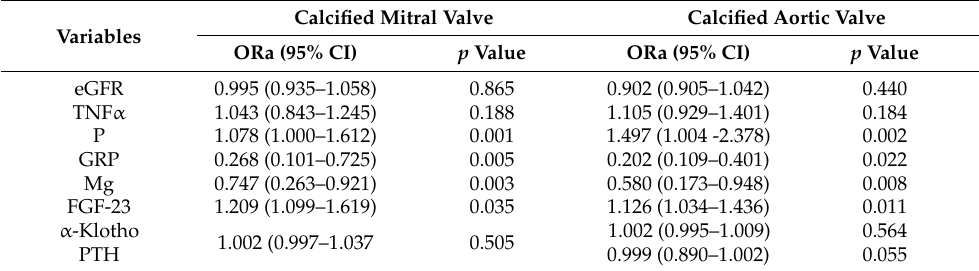
Table 5. GRP is an independent risk factor associated with mitral and aortic valves